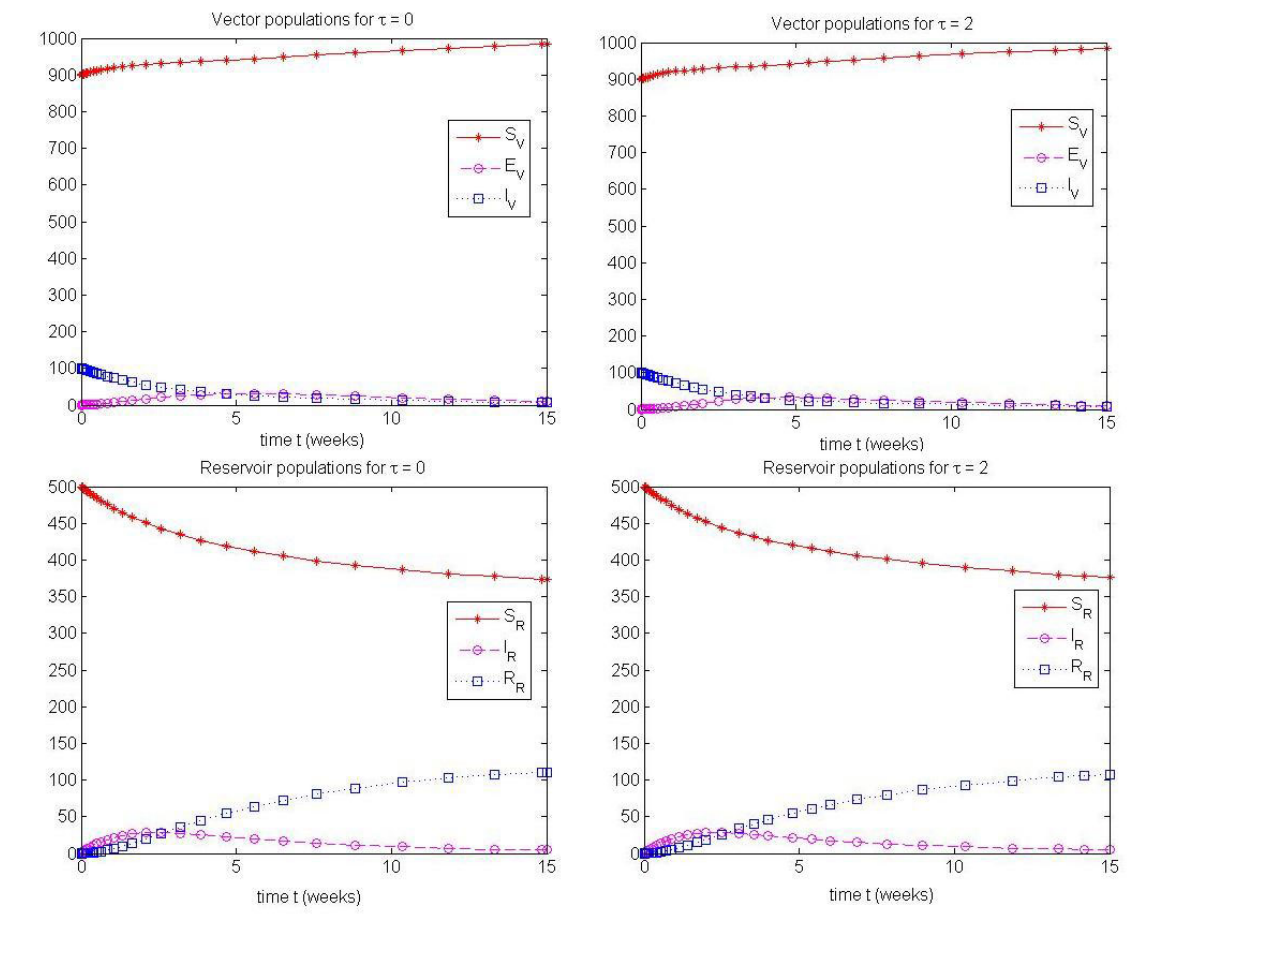
Fig. 5. Comparison of simulations of vector population growth with no time lag ( t = 0) to vector population growths with a 2-week time lag ( t = 2) (A). Comparison of simulations of reservoir population growth with no time lag ( t = 0) to reservoir population growths with a 2-week time lag ( t = 2)